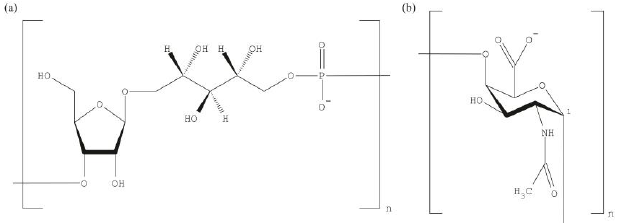
Figure 1. Repeating polysaccharide units of bacterial capsules. ( a ) The polyribosylribitol phosphate (PRP) repeating unit of Haemophilus influenzae type b (Hib) consists of two riboses (one reduced to ribitol) linked to a phosphate; ( b ) The capsular Vi antigen of S. typhi is built from a single sugar: N -acetyl galactosaminouronate. The monomeric Vi repeating units are α-1-4 linked.